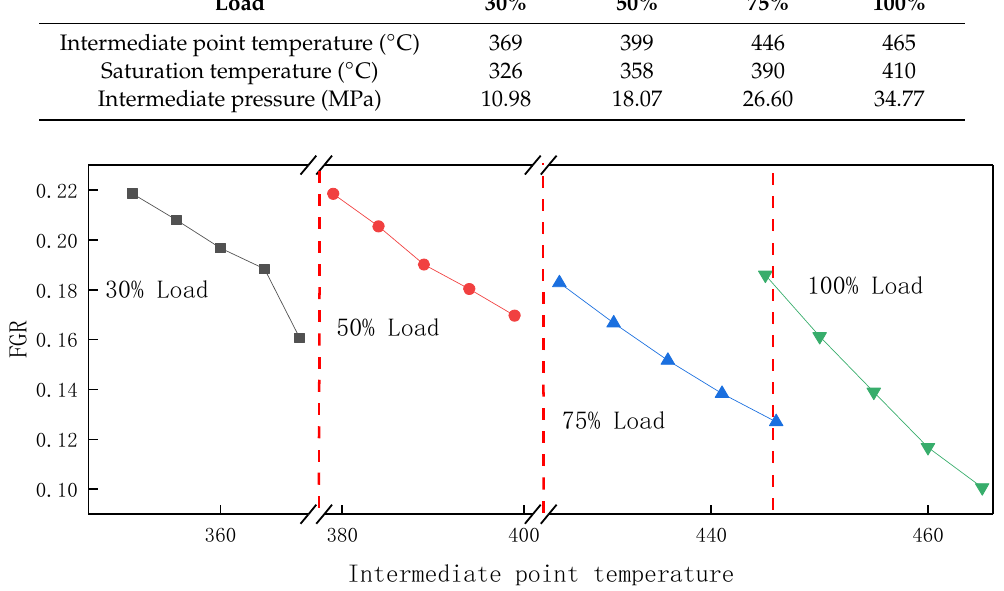
Figure 7. Change of FGR rate when the intermediate point temperature of the reference system changes.